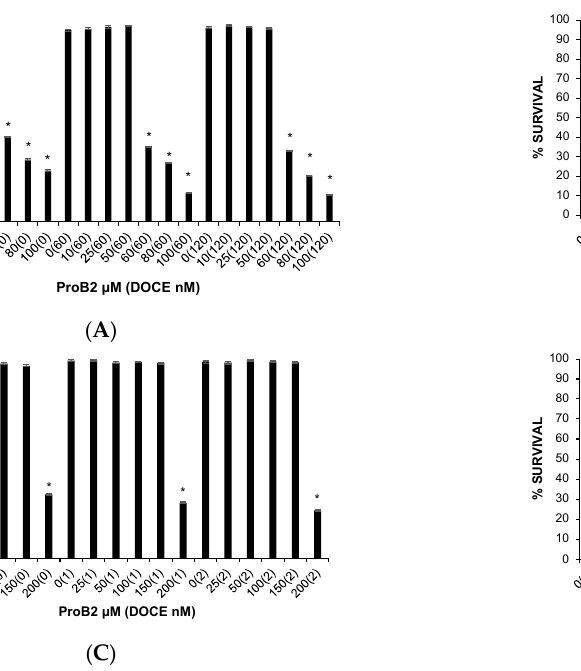
Figure 1. Effect of single or combined therapy on proliferation of healthy cells (trypan blue dye exclusion assay). ( A ) Effect of different concentrations of ProB2 (10–100 µM), with and without DOCE (60–120 nM) on healthy mammary cells. ( B ) Effect of different concentrations of CAT (5–50 µM), with and without DOCE (60–120 nM) on healthy mammary cells. ( C ) Effect of different concentrations of ProB2 (25–200 µM), with and without DOCE (1–2 nM) on healthy prostate cells. ( D ) Effect of different concentrations of CAT (50–150 µM), with and without DOCE (1–2 nM) on healthy prostate cells. The data are means ± SD (n = 3). * p < 0.05, significantly different compared with control treatment. Abbreviations: CAT, catechin; DOCE, docetaxel; ProB2, procyanidin B2. Table 1. Effect of ProB2 and CAT on proliferation of (A) healthy prostate and (B) healthy mammary cells (72 h).